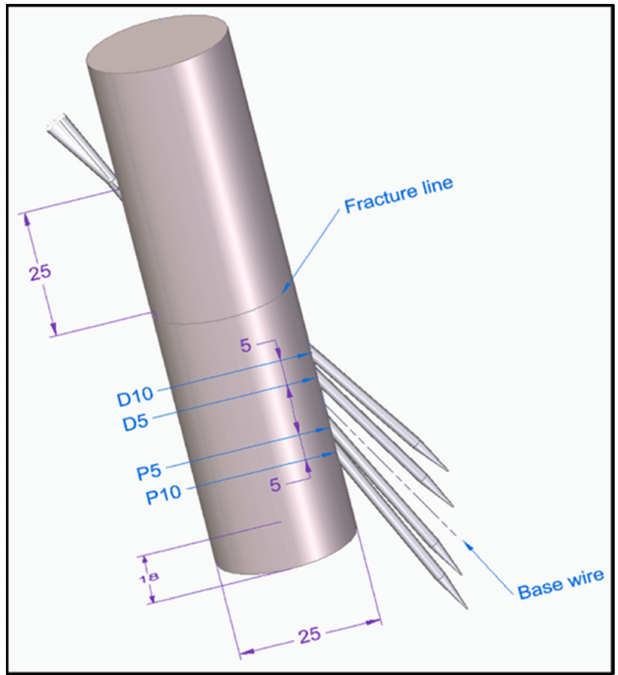
Figure 4. The dashed line represents Group III (base wire). In the figure, four different fixation setups (gray needles) are illustrated on a single model to visualize the difference between the Group III. Subgroups: D10—distal 10 mm, D5—distal 5 mm, P5—proximal 5 mm, P10—proximal 10 mm. The purple arrows depict both the location of the entry and the exit points of the wire including the diameters of the